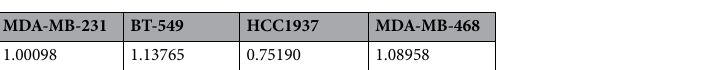
Table 2. Combination index (CI) values at ED50 for the combination of chelerythrine and